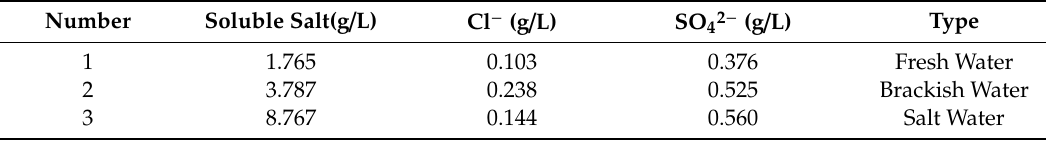
Table 2. The content of soluble salt, SO 42− ion, and Cl − ion of cement-stabilized macadam base materials in filed. Table 3. The content of soluble salt, SO 42 − ion, and Cl − ion in